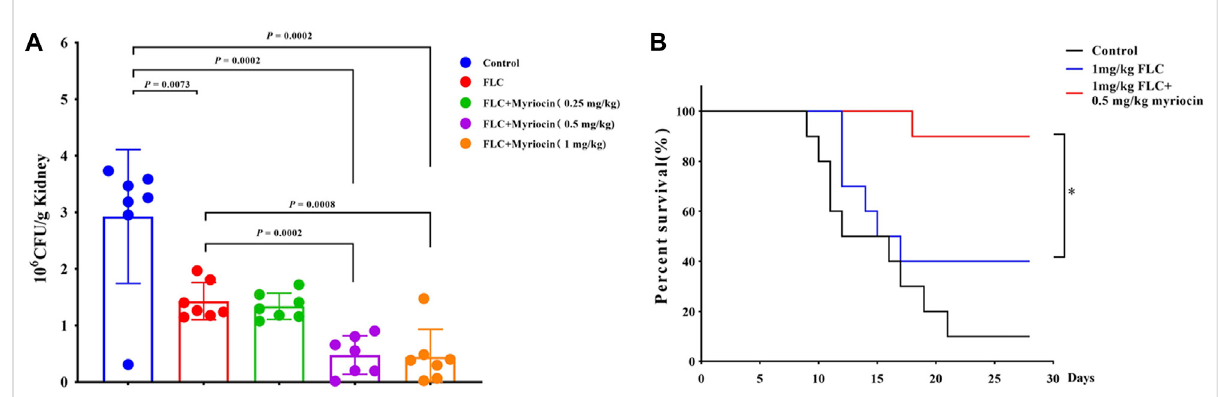
FIGURE 5 Myriocin enhances the antifungalactivityagainst C. albicans in vivo . (A) Kidney CFU assay in mice with systemic candidiasis after treatment with PBS,FLC(1 mg/kg),FLC(1 mg/kg)+myriocin(0.25 mg/kg),FLC(1 mg/kg)+myriocin(0.5 mg/kg),andFLC(1 mg/kg)+myriocin(1 mg/kg)for3 days. (B) Survival curves of C57BL/6 mice infected by SN152 and treated with FLC (1 mg/kg) or FLC (1 mg/kg) + myriocin (0.25 mg/kg) for 3 days, * p = 0.0137 (Log-rank